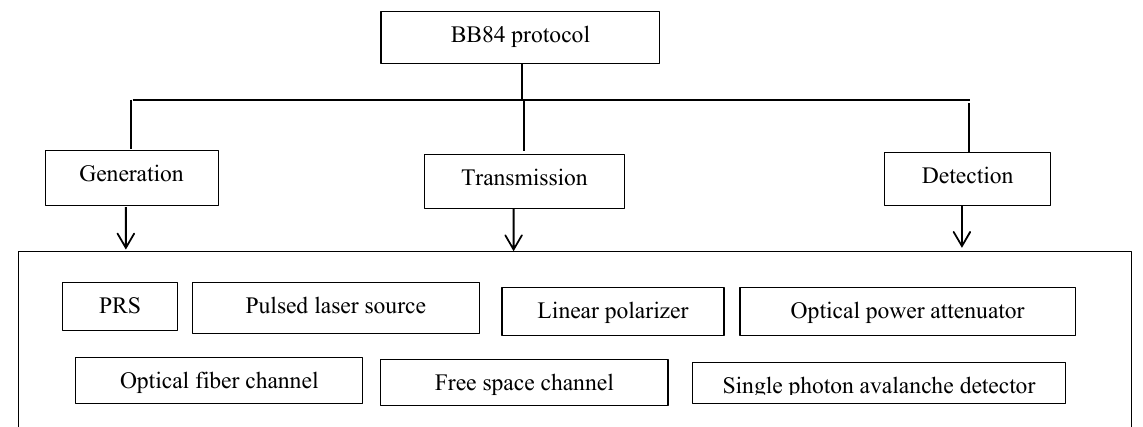
Fig. 3. QKD simulator reference